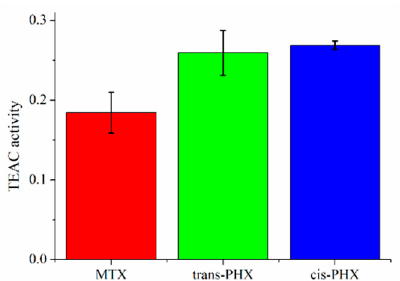
Figure 7. Trolox equivalent antioxidant capacity (TEAC) of methotrexate (MTX), trans -phototrexate ( trans -PHX), and cis -phototrexate ( cis -PHX) measured by ABTS radical scavenging assay. Data rep- resent the mean ± SD ( n = 3).